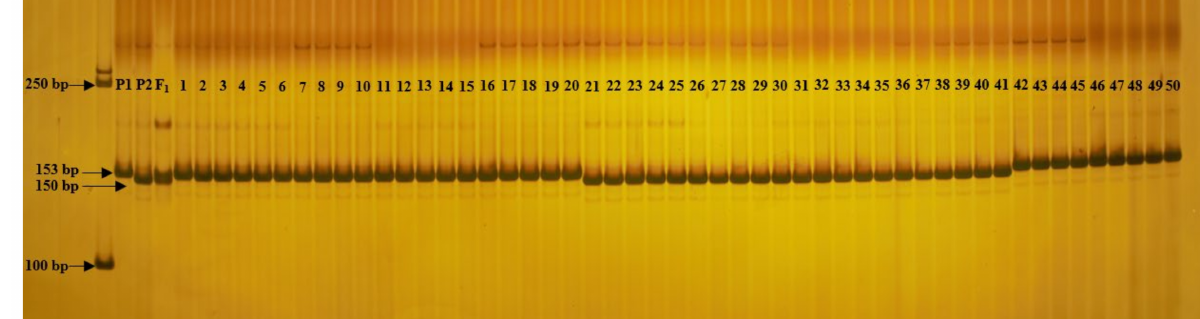
Figure 5. InDel is marked for verifying 50 parts of wax gourd material, where PI is the parent, P2 is the mother, 1–2 is SL-7 and XDJQ-1, 1–20 is 20 parts of high-SSC wax gourd material, and 21–50 is 30 parts of low-SSC wax gourd